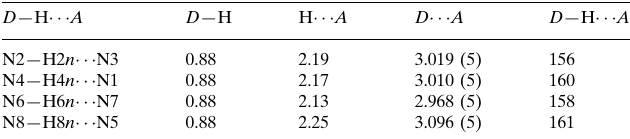
Hydrogen-bond geometry (A˚ , (cid:2)